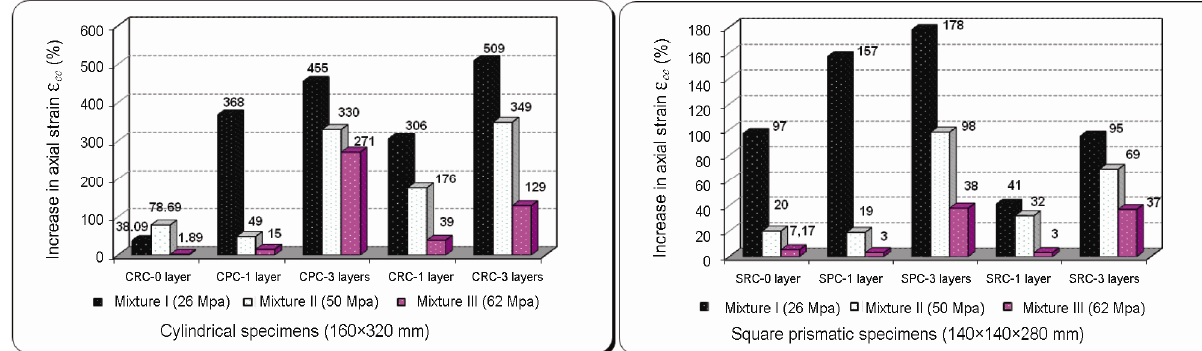
Fig. 7. Effect of unconfined strength of concrete on peak